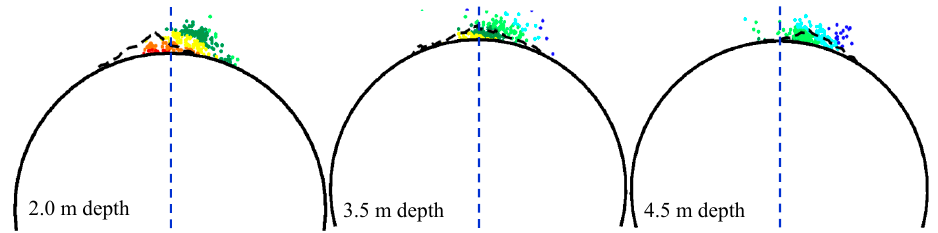
Figure 10. The location of the acoustic emission events at different depths [35], courtesy of SKB (from SKB TR-07-01 (Andersson